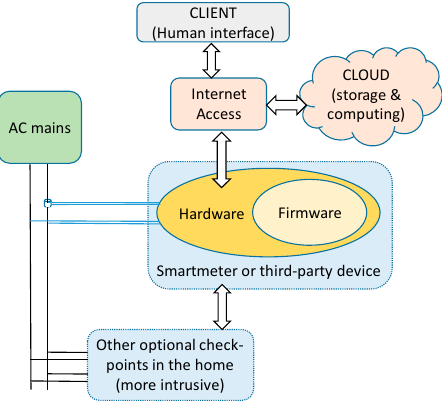
Figure 5. General diagram of systems that use NILM in AAL.